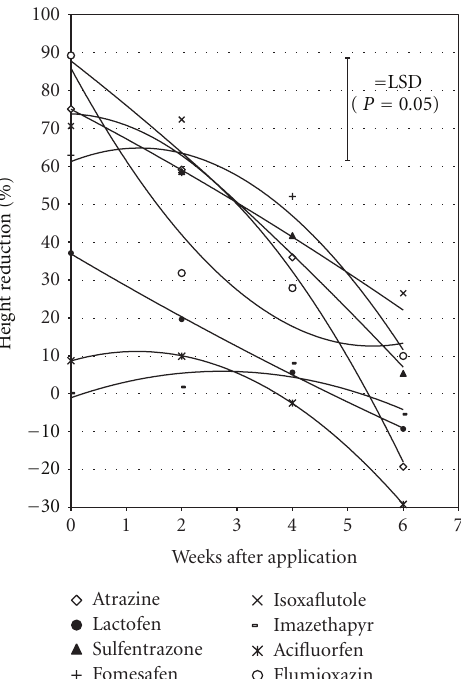
0102030405060708090100 0 Figure 2: Preemergence height reduction of common waterhemp with acifluorfen at 420g/ha ( y = − 1 . 7456 x 2 + 4 . 1766 x + 8 . 6638, R 2 = 0 . 99), flumioxazin at 72g/ha ( y = 2 . 4673 x 2 − 26 . 885 x + 85 . 82, R 2 = 0 . 94), fomesafen at 330 g/ha ( y = − 2 . 3471 x 2 + 5 . 8131 x + 61 . 191, R 2 = 0 . 97), lactofen at 220 g/ha ( y = 0 . 1593 x 2 − 8 . 6097 x + 36 . 875, R 2 = 0 . 99), sulfentrazone at 240 g/ha ( y = − 0 . 3426 x 2 − 11 . 394 x +87 . 74, R 2 = 0 . 98), atrazine at 1680 g/ha ( y = − 2 . 4501 x 2 − 0 . 595 x + 73 . 805, R 2 = 0 . 99), imazethapyr at 70g/ha ( y = − 0 . 9401 x 2 + 5 . 1214 x − 1 . 0435, R 2 = 0 . 67), and isoxaflutole at 70 g/ha ( y = − 0 . 2015 x 2 − 7 . 6133 x + 75 . 009, R 2 = 0 . 80) 28 days after planting when planted 0, 2, 4, and 6 weeks after application. The vertical line represents the LSD ( P = 0 .